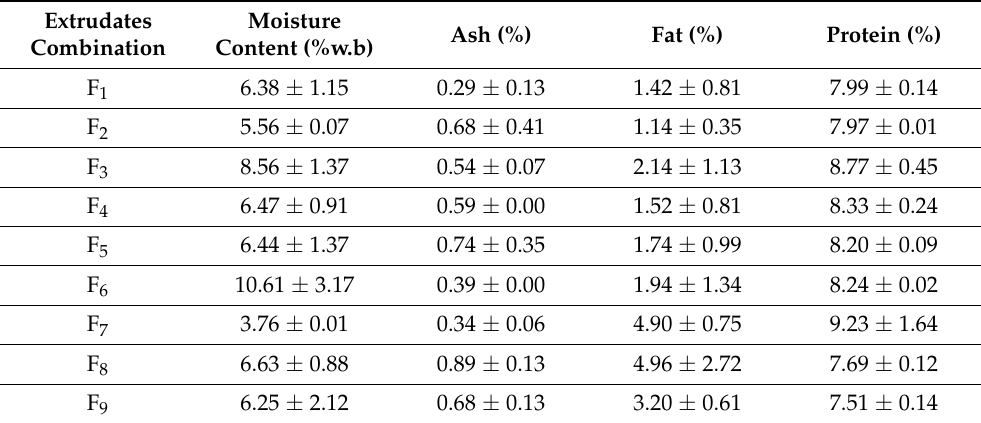
Table 9. Proximate composition of neera honey incorporated